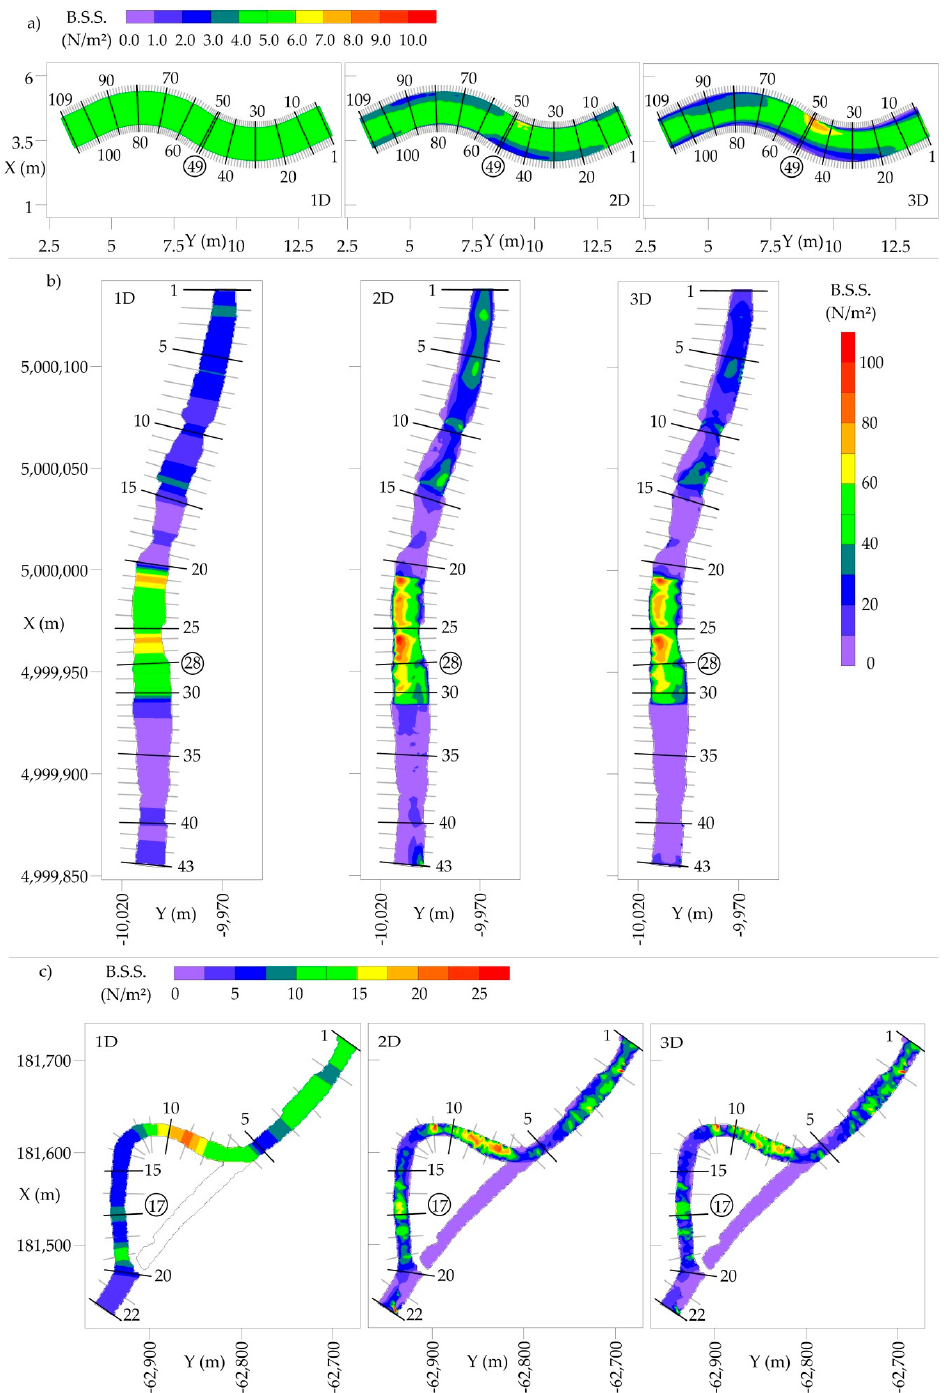
Figure 4. Comparison of bed shear stresses calculated by 1D/2D/3D models depicted for ( a ) C.1, ( b ) C.2 at Q M and ( c ) C.3 at Q M .